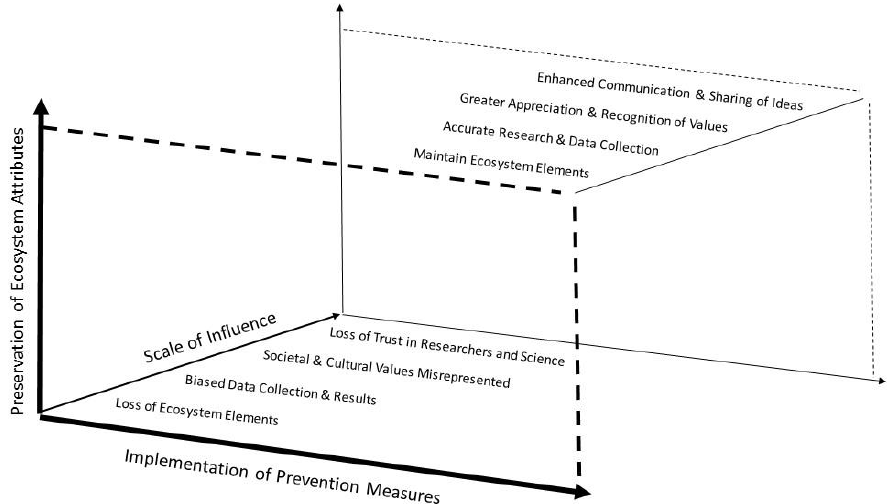
Figure 4. Consequences from research-induced impacts result in a cascading scale, ranging from local disturbances to broader societal consequences. When no preventative measures are taken, researchers’ fail to fulfill their duty at the site level, and this can lead to a loss of trust in science at the societal scale. Embracing preventative measures allows ecosystem attributes to persist and leads to greater appreciation of wetlands and enhanced communication between stakeholders.